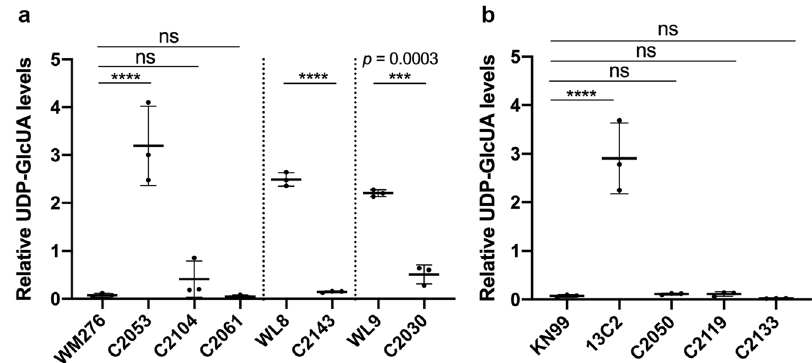
Fig. 5 The levels of UDP-glucuronic acid are high in the uxs1 mutants and low in the suppressor strains. Nucleotide sugars were analyzed as described under “ Methods ” . Relative amounts of UDP-glucuronic acid were determined in strains derived from WM276 ( a ) and KN99 α ( b ). The experiments were repeated three times and data are presented as mean values ± standard deviation. One-way ANOVA with Tukey ’ s test for multiple comparisons (ns = not signi fi cant, *** p < 0.0002, and **** p <